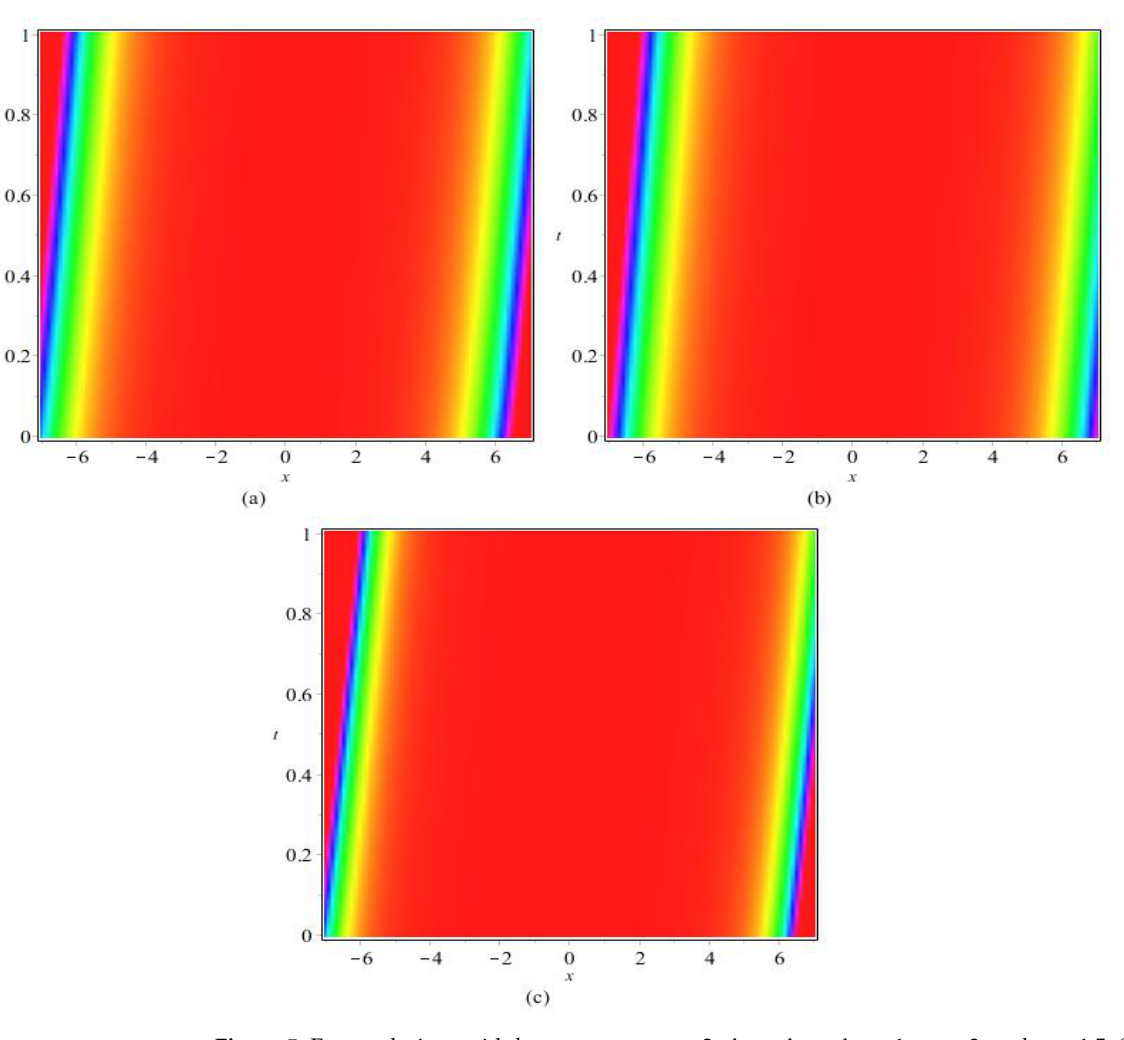
Figure 5. Exact solutions with k 1 = α 1 = a = c = 2, λ 1 = λ 2 = λ 3 = 1, m = 3, and n = 1.5, β = α = 0.9 w.r.t. ( a ) M-derivative (21), ( b ) beta-derivative ( c )